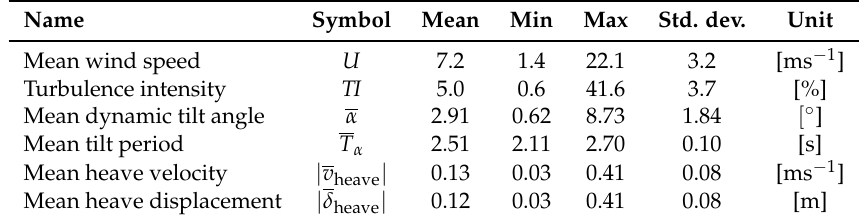
Table 1. Overview of wind conditions and motion state of the buoy during the periods that are included in the results section. Wind conditions as measured by the fixed reference